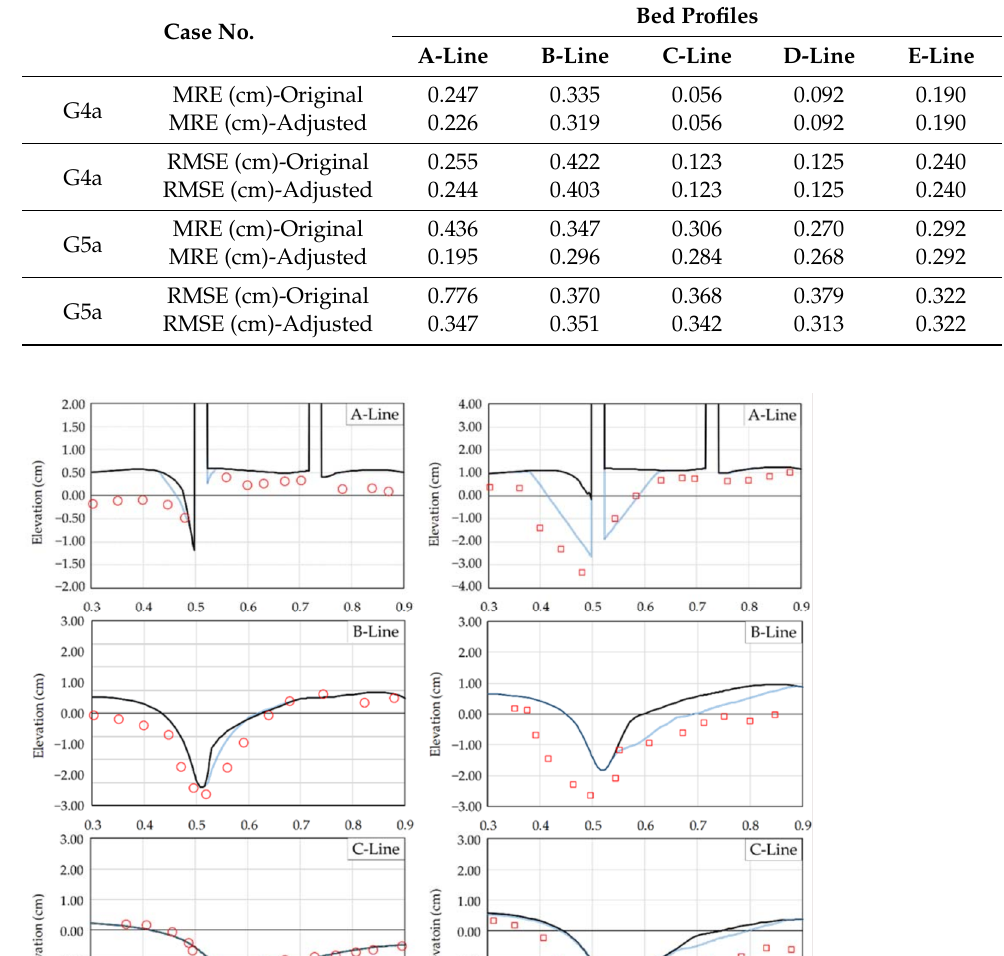
Table 4. Comparison of the Mean Relative Errors (MREs) and Root Mean Square Errors (RMSEs) along the bed profiles from the A-line to the E-line.